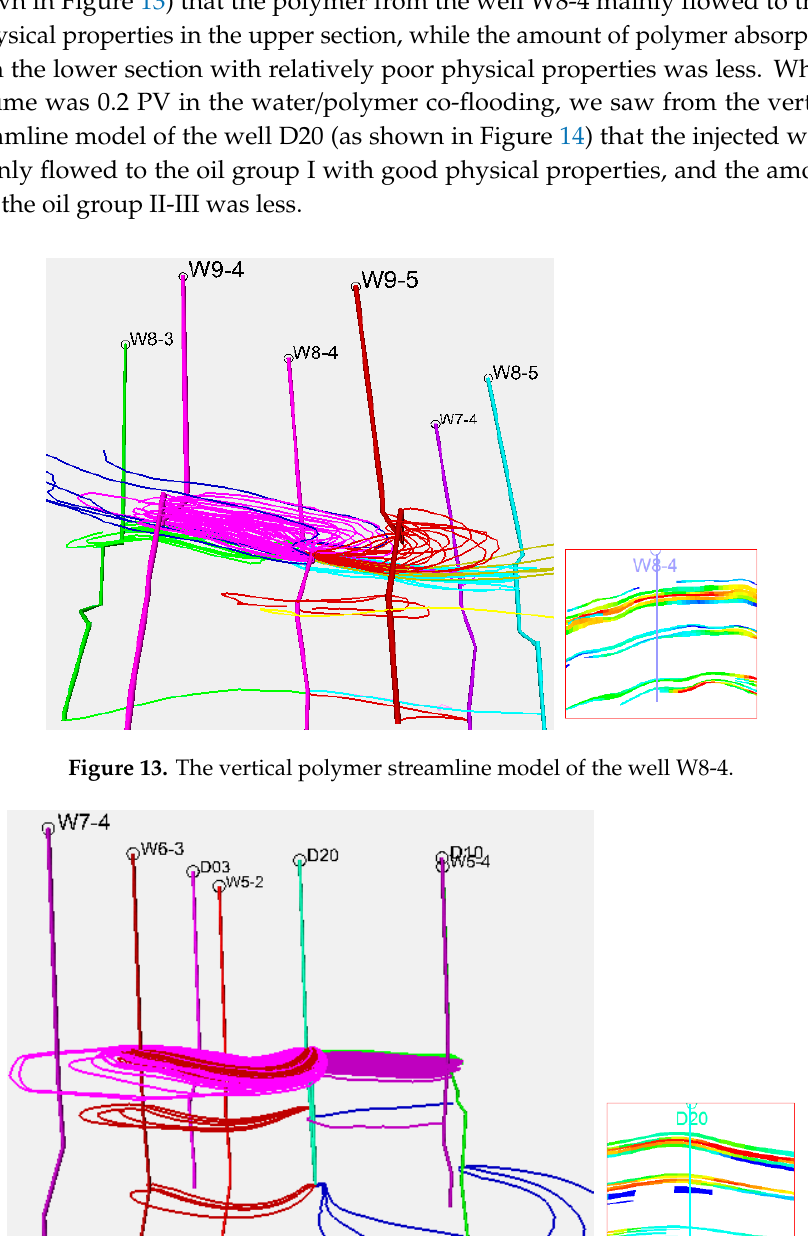
Figure 12. The water and polymer flooding status in the later stage of the water/polymer flooding of the oil group I.